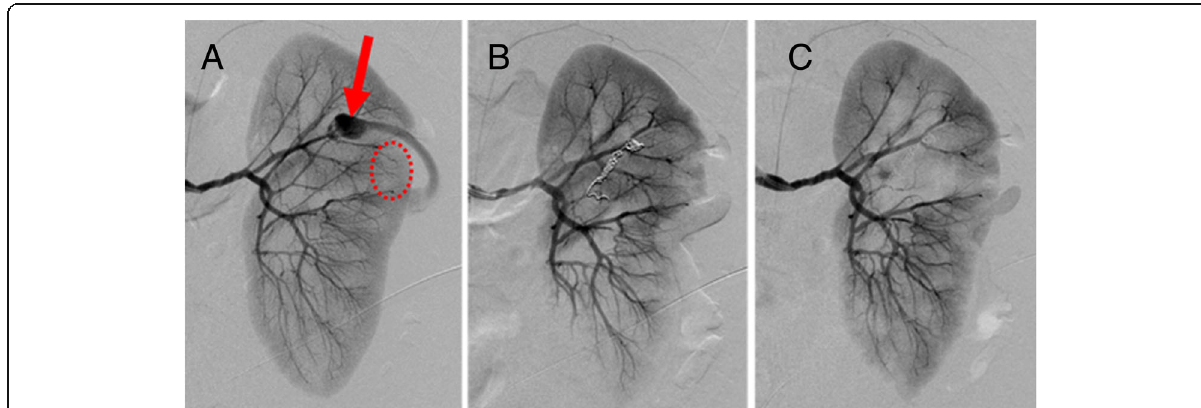
Fig. 2 Transcatheter arterial embolization (TAE). a Angiography reveals two locations of contrast leakage in the left upper kidney before TAE. Arrow indicates renal artery aneurysm (RAA) and extravasation of contrast media. Circle indicates defect of contrast media in the kidney parenchyma. b Coil embolization is performed for RAA. c When contrast perfusion in the kidney parenchyma is lost, embolization is performed with gelatin